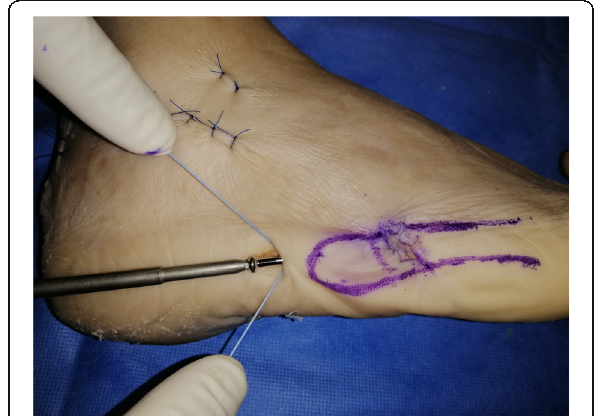
Fig. 6 The screw is then tightened, the Fiberwire® cerclage is properly tensioned and securely